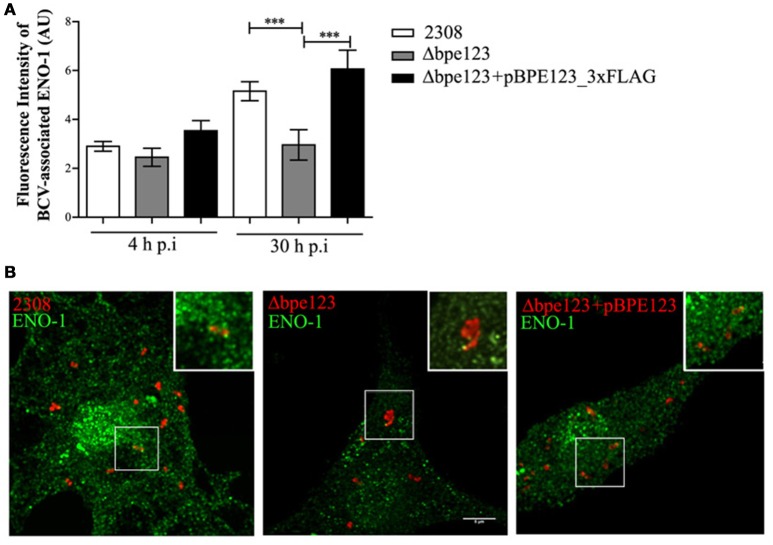
ENO-1 accumulates in the vicinities of BCVs. (A) Quantification of fluorescence intensities (Arbitrary Units) of BCV-associated ENO-1 in BMDM infected with the indicated strains of mCherry-tagged B. abortus at 4 and 30 h (p.i.). Quantitative analysis was based on examination of at least 500 infected cells. The data represent analyses of the mean and standard deviations and are representative of two independent experiments. ***P < 0.001 (unpaired t-test). (B) Representative confocal micrographs of bone marrow-derived macrophages infected with the indicated strains of mCherry-tagged B. abortus at 30 h p.i. Infected cells grown on coverslips were stained with anti-ENO-1 antibody (green). Magnified insets show overlay color images of the boxed region. Scale bar, 5 μm.